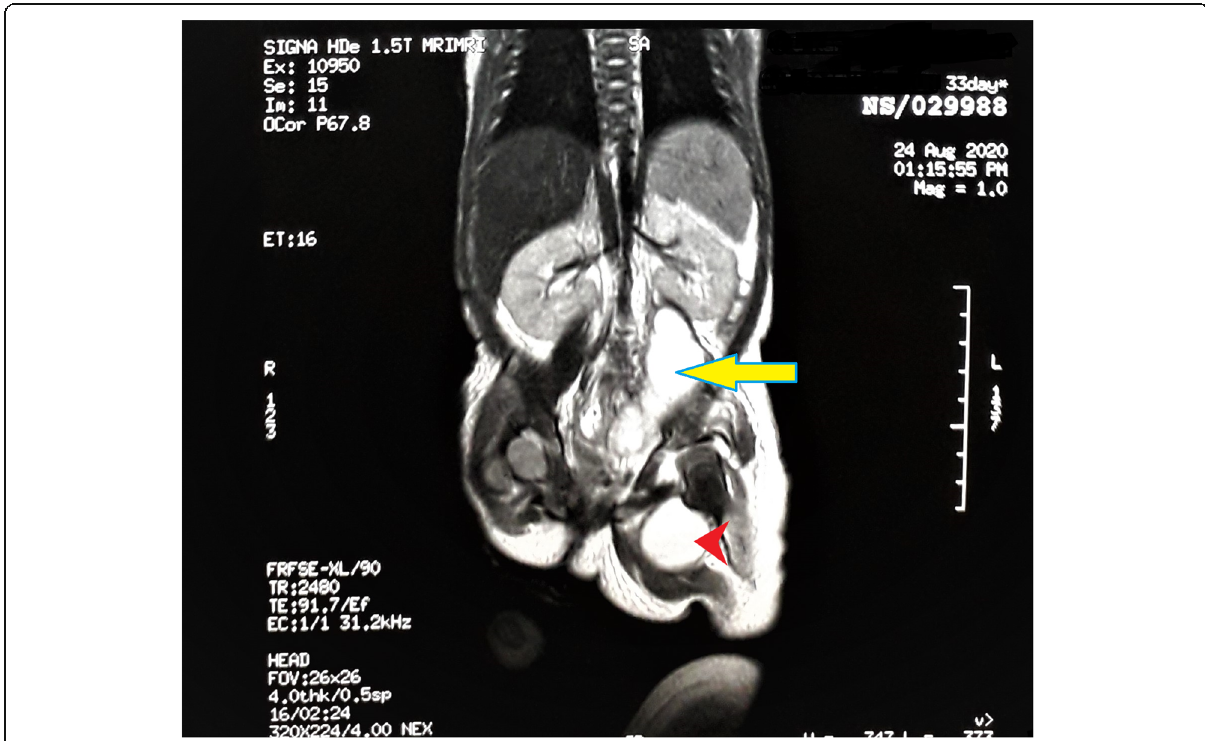
Fig. 2 Magnetic resonance imaging showing thick-walled abscess (59.7 mm × 31.9 mm) along the left psoas muscle ( yellow arrow ) extending from the level of lower border of the left kidney superiorly up-to left proximal thigh inferiorly ( red arrow head